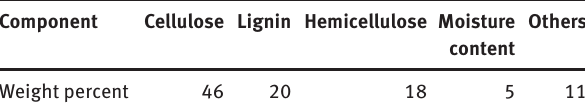
Table 1: The compositions of DPF [6]. Component